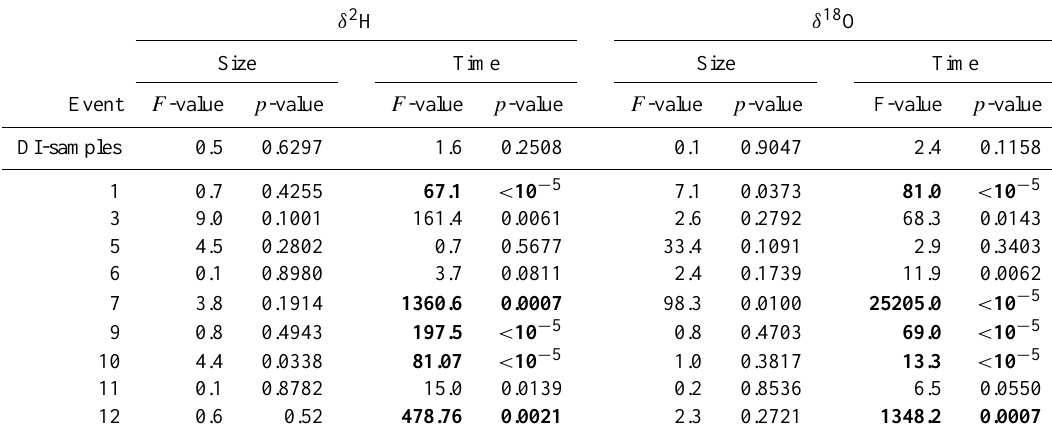
Table 1. F - and p -values for a two way ANOVA (factors: Time and Size) for the measured δ 2 H and δ 18 O values for the six DI-samples and for each cloud event separately comprising more than one cloud sample. The factor Time is represented by the sample number within an event and was used as a categorical variable in the ANOVA. Bold indicates that the null hypothesis needs to be rejected at a significance level α = 0 . 05 (H 0 (events): Cloud water from all vials have the same δ values; H 0 (DI-samples): Water from all vials have the same δ values as the DI water). For events 1, 5, 7 and 12, the ANOVA was only performed for δ values from stage 1 and 3, as at least one δ value for the stage 2 was missing. As there were 18 independent tests necessary for the cloud events, we applied the Bonferroni correction (Legendre and Legendre, 1998) resulting in an adjusted significant level α adj = 0 . 05 / 18 = 2 . 7 × 10 − 3 against which the p -values were compared. δ 2